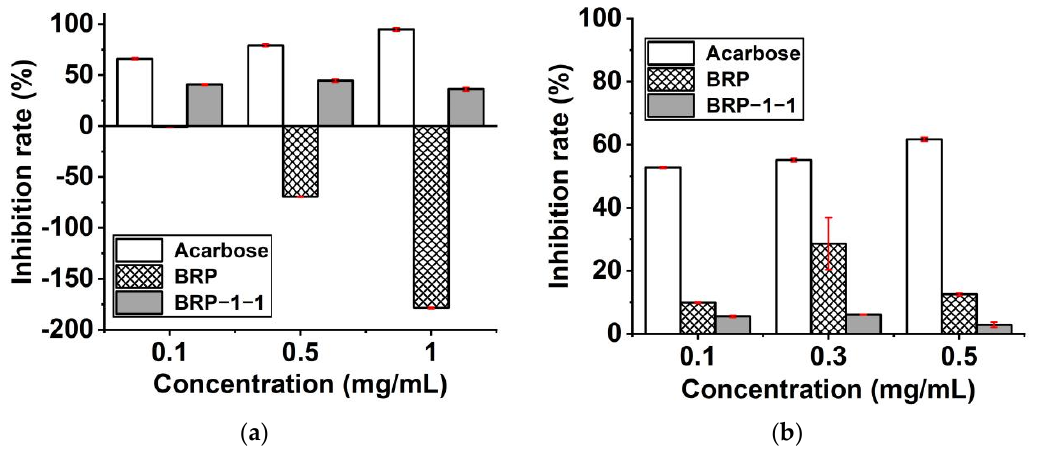
Figure 7. ( a ) α -Glucosidase inhibitory assay; ( b ) α -amylase inhibitory assay.